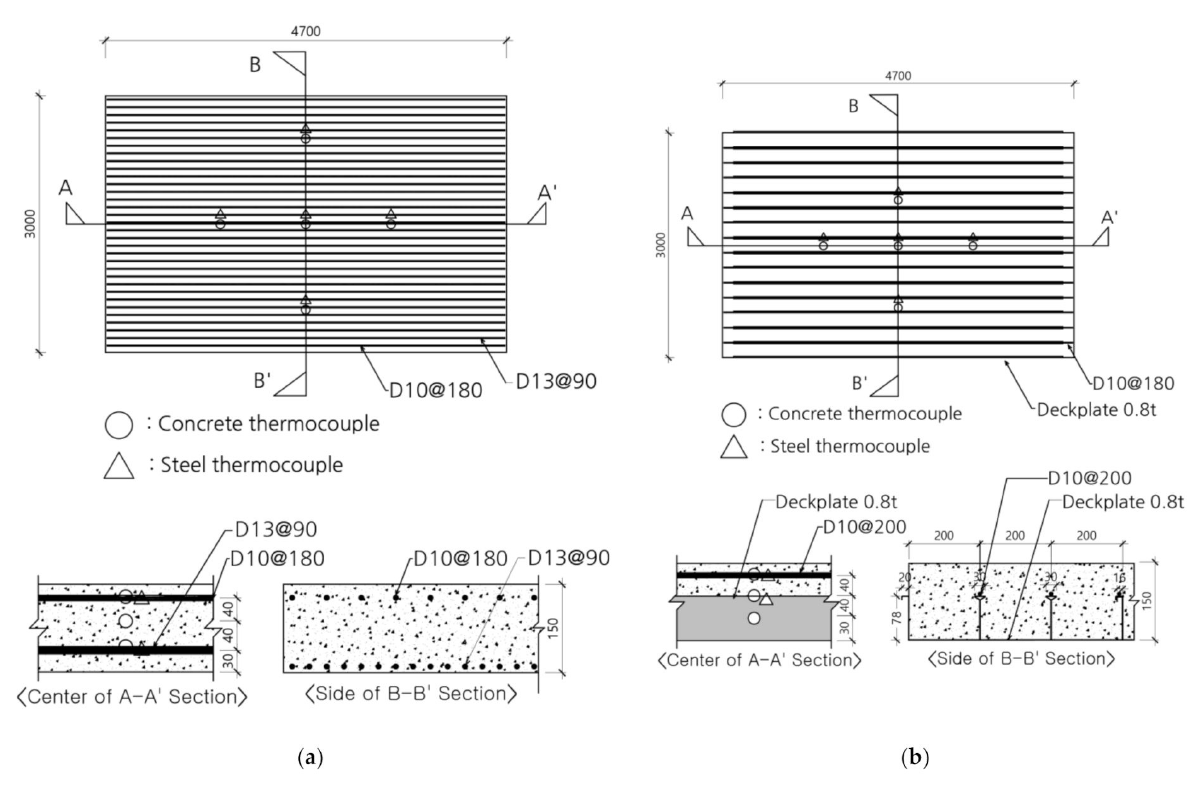
Figure 4. Details of the specimens and location of the thermocouple (unit: mm). ( a ) RC-0. ( b ) Deck-0,